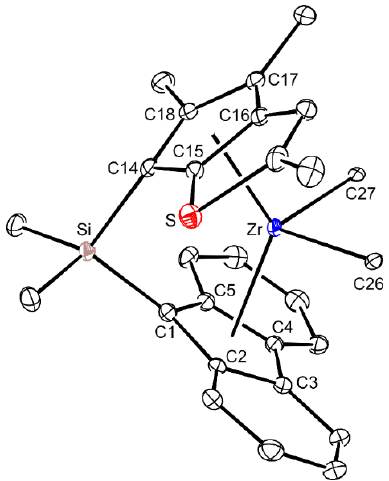
Figure 1. Thermal ellipsoid plot (30% probability level) of 9 . Selected bond distances (Å) and angles